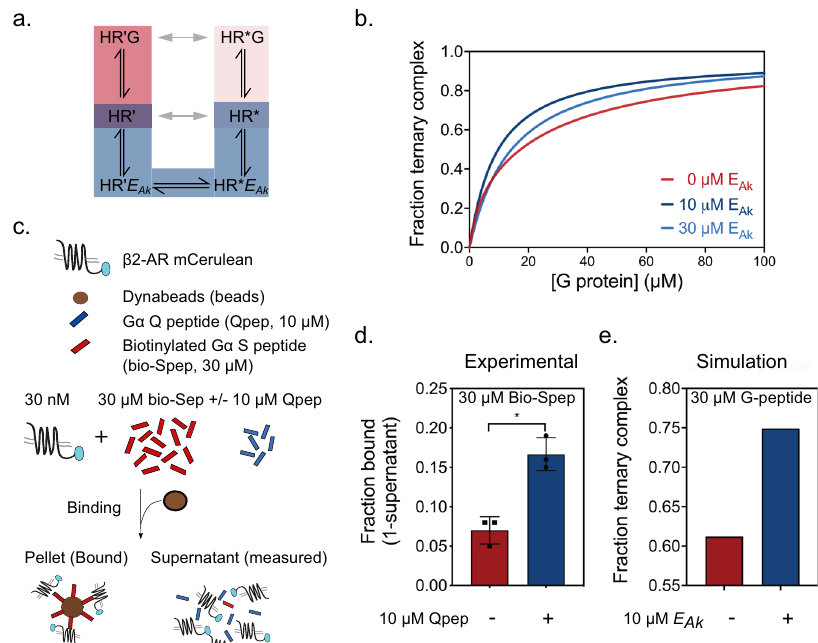
Fig. 2 Allokairic Effector (EAk) increases ternary complex formation. a Extended model incorporating an allokairic effector ( E Ak ) . b Transient simulations show increases in ternary complex as the concentration of G protein increases (red), which is further enhanced by the presence of E Ak (blue). c Schematic of the af fi nity sequestration assay experimental procedure. d 30 μ M bio-Spep binds β 2AR – mCer in native membranes (red). The addition of 10 μ M Qpep acting as E Ak increases β 2AR – mCer binding to bio-Spep 2-fold (blue). Data are presented as the mean + / − standard deviation from 3 independent membrane preparations ( n = 3) * p = 0.035 in two-sided, paired t-test. e Transient simulations show ternary complex with 30 μ M G peptide present (red) in the absence and presence of 10 μ M E Ak (blue). Simulation parameters in S Table 1. Source data are provided in the Source Data